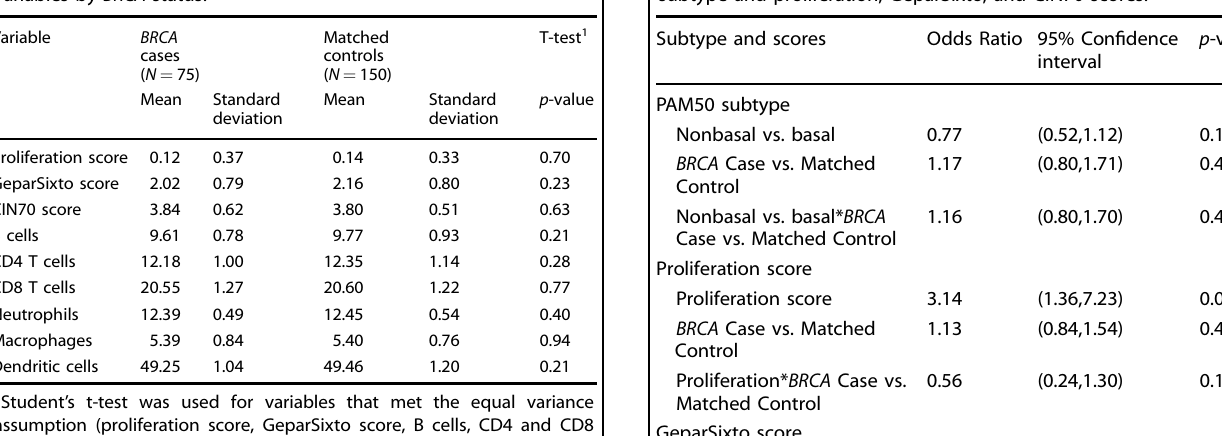
Table 2. T-tests comparing proliferation, GeparSixto, and TIMER variables by BRCA status.